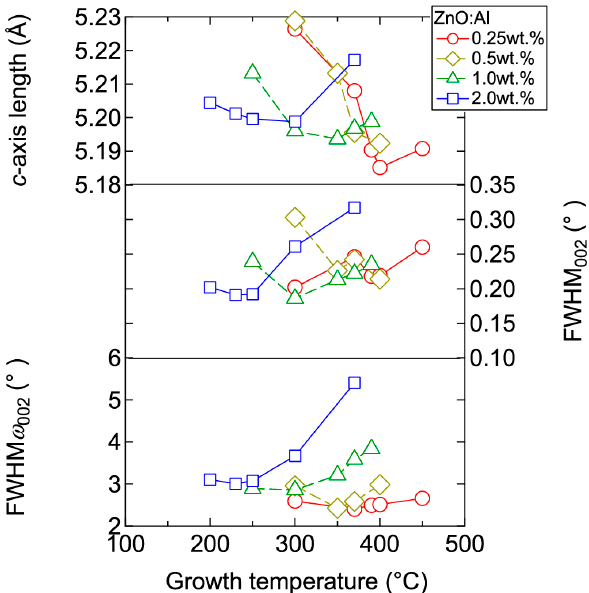
Figure 3. Plots of c -axis length, the full width at half maximum (FWHM) of the 002 diffraction peak (FWHM 002 ), and the FWHM of rocking curves for the 002 diffraction peak (FWHM ω 002 ) as a function of growth temperature for ZnO:Al (0.25, 0.5, 1.0, and 2.0 wt %) films.